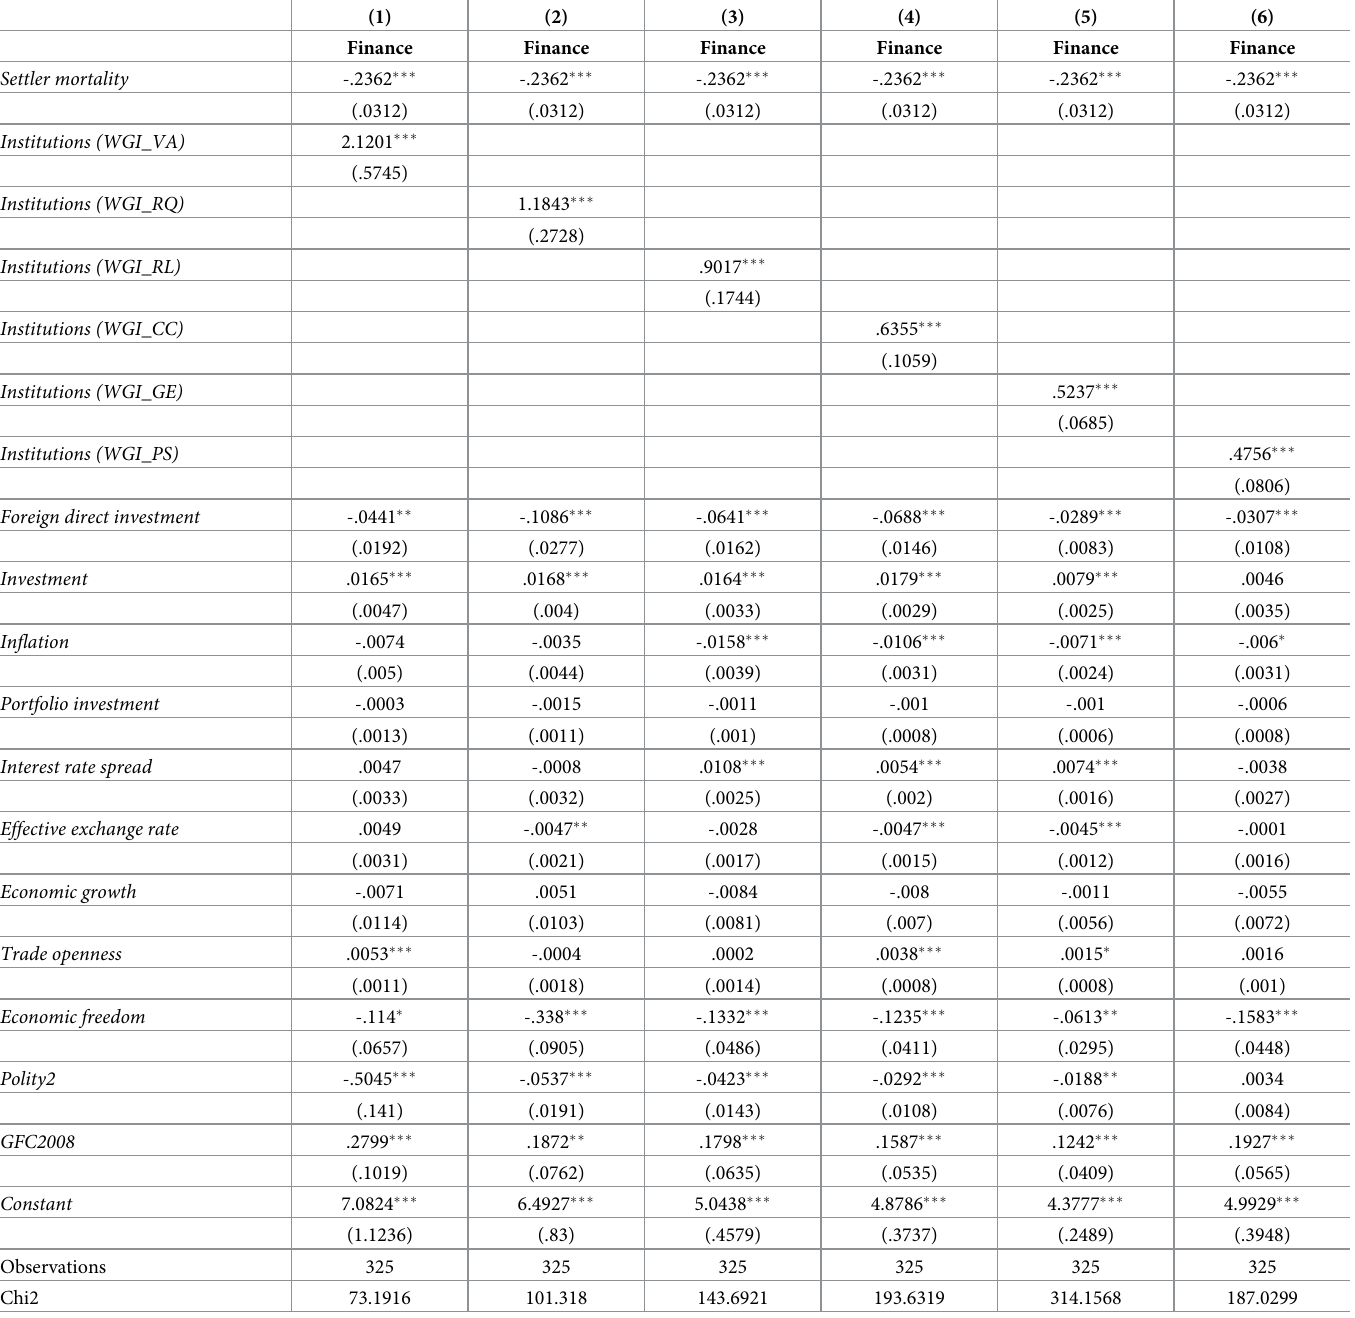
Table 7. Robustness with subdimensions of institutions